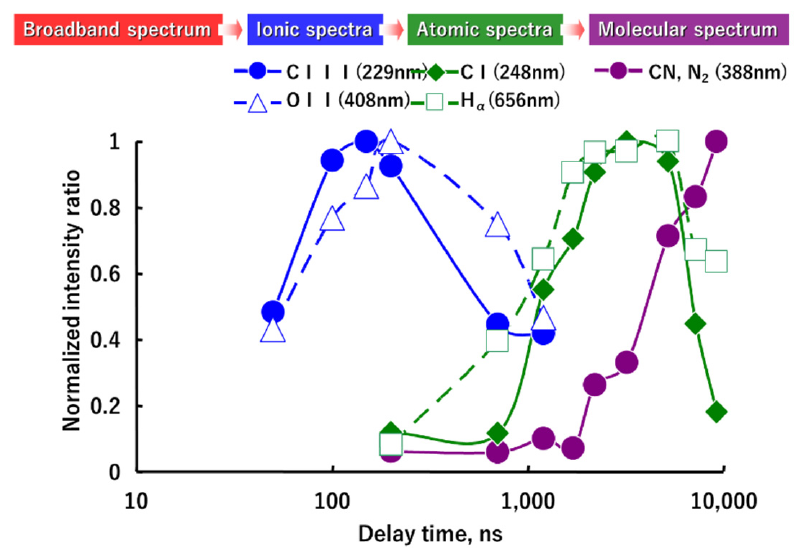
Figure 10. Intensity profile of ionic, atomic, and molecular spectra. The ionic spectra have a shorter lifetime compared with the atomic and molecular spectra.